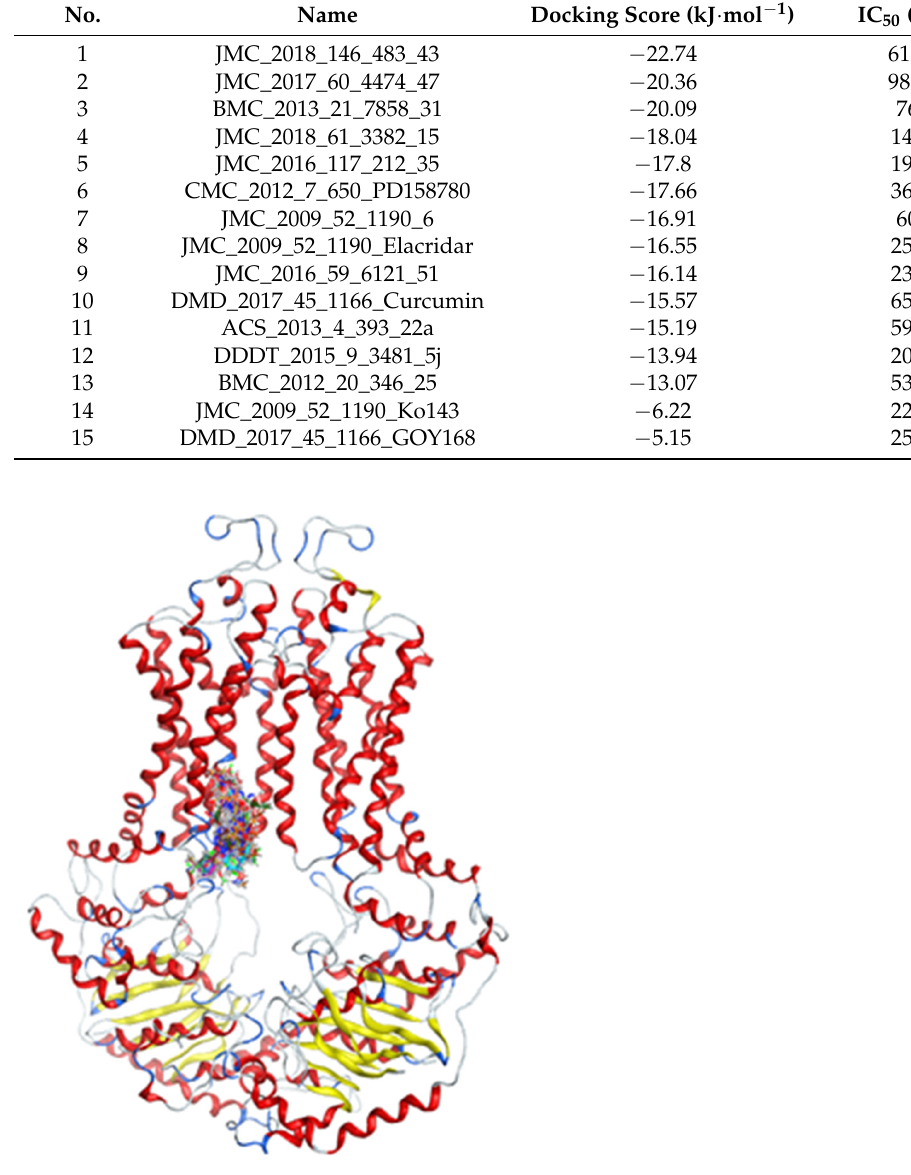
Figure 9. Binding sites of 325 substances on the ABCG2 protein. Figure 9 . Binding sites of 325 substances on the ABCG2 protein . Table 6. Frequency of amino acids interacting with amino acids in the binding